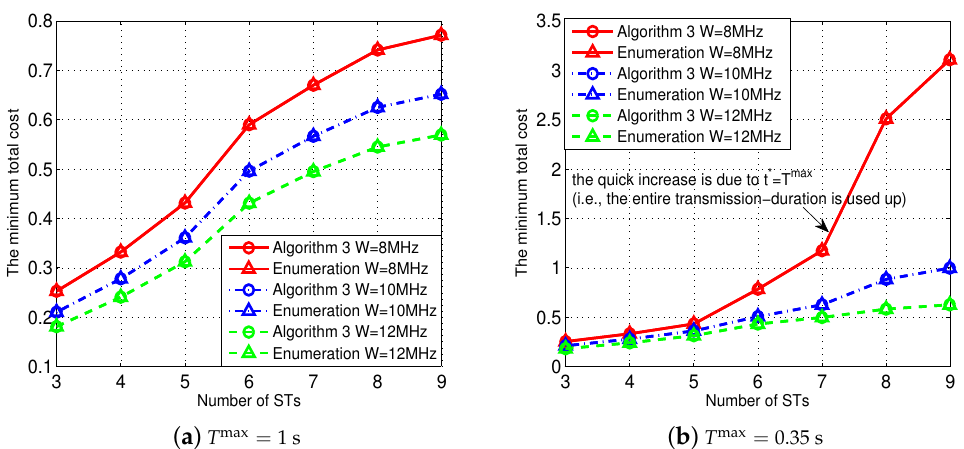
Figure 6. Performance of our proposed NOMA-transmission scheme under different numbers of STs.